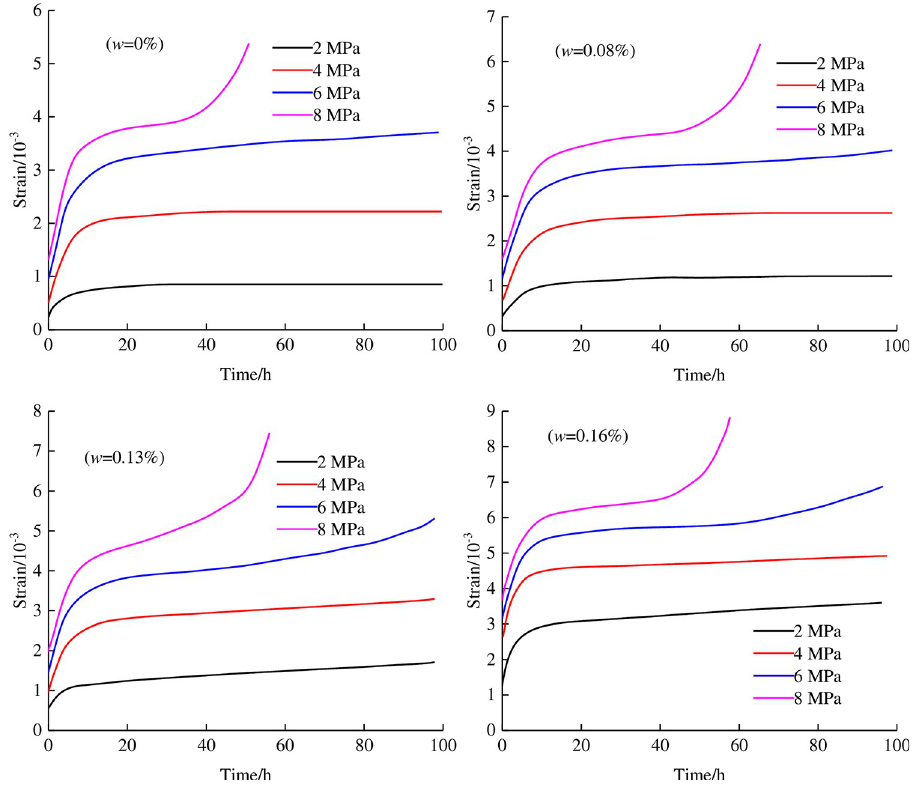
Fig 5. Shear creep curves of the anchorage rock mass under different water